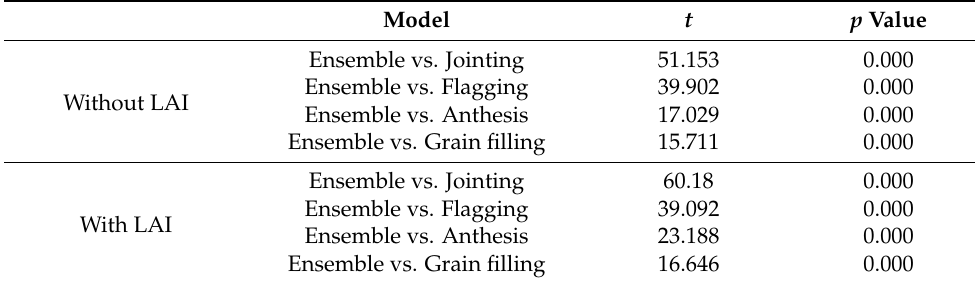
Table 5. Results from the paired sample t